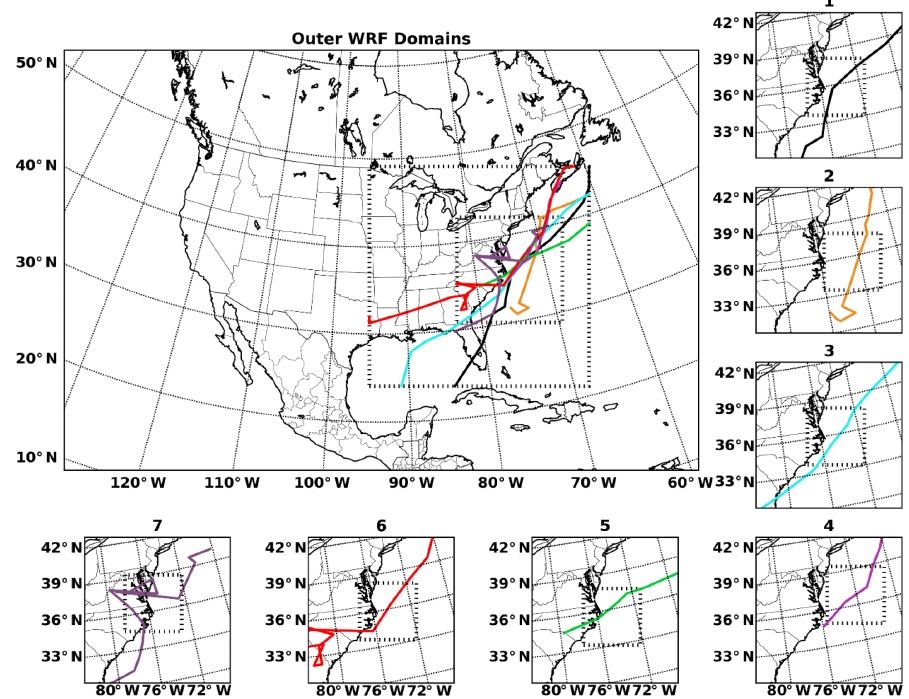
Figure 1. Nested WRF configuration used in simulations. The large panel shows the first three model domains (45, 15, 5km grid spacing, respectively). The smaller panels show the location of domain 4 (1.667km resolution) for each of the seven cases. The colored lines show the cyclone track as indicated by GMA for each nor’easter case. Table 1. Nor’easter case list. The Northeast Snowfall Impact Scale (NESIS) number is included for storm severity reference. Mean sea-level pressure (MSLP) indicates maximum cyclone intensity in GMA. The last two columns denote the first and last times for each model run. GMA storm tracks are displayed in Fig.